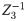
RMS coma (Z3−1 and Z31) values of the designed IOLs for misalignment (left column) and tilt (right column) with each different cornea: A) Normal, B) Myopic, C) Hyperopic.